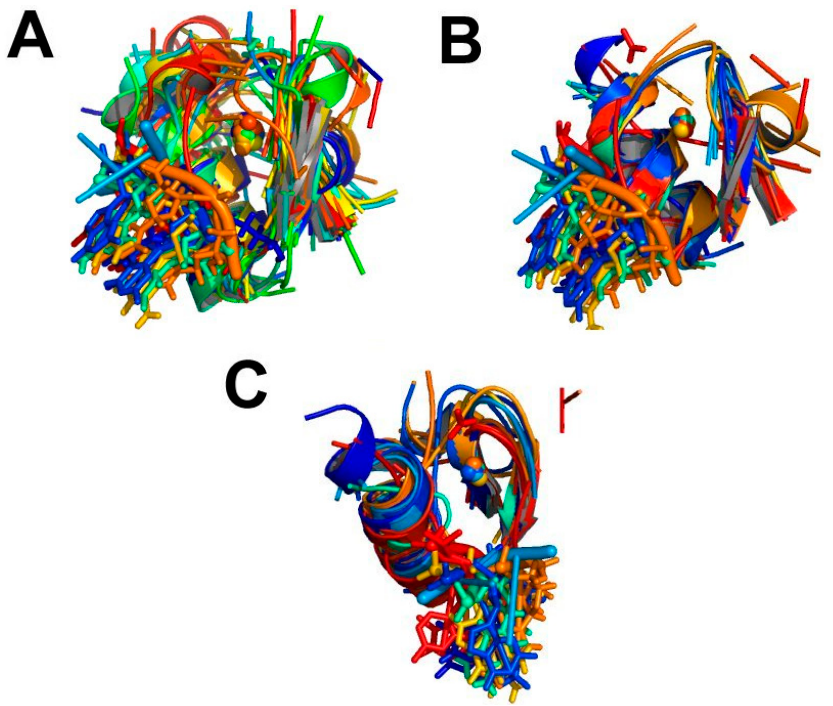
Figure 7. A cluster of representative zinc-binding MFSs containing 99 sites. Each MFS is assigned a different color (rainbow from 1 to 99), maintained in all panels. The zinc ions are shown as spheres. ( A ) Superposition of all 99 sites; ( B ) same as ( A ), but showing only the sites with an organic ligand bound; ( C ) a rotated top view of B.